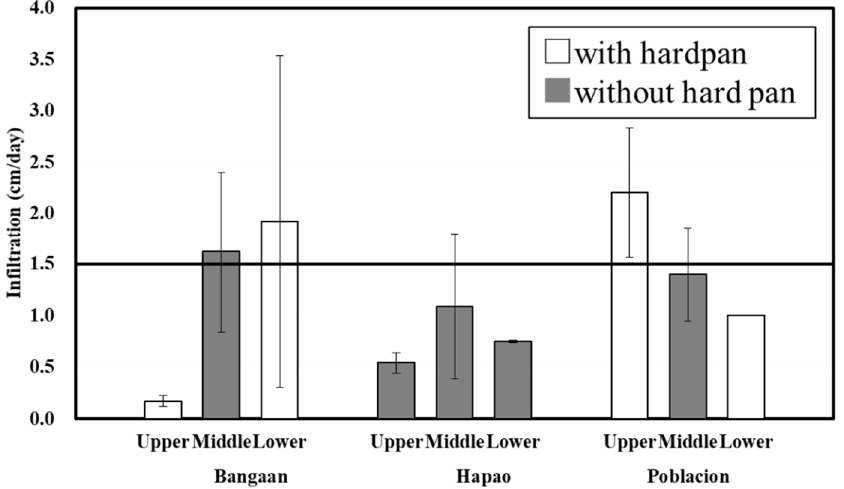
Figure 4. Infiltration rate (cm / day) for Bangaan, Hapao, and Poblacion. Measurement was conducted only once in the lower fields of Poblacion owing to gas emission.